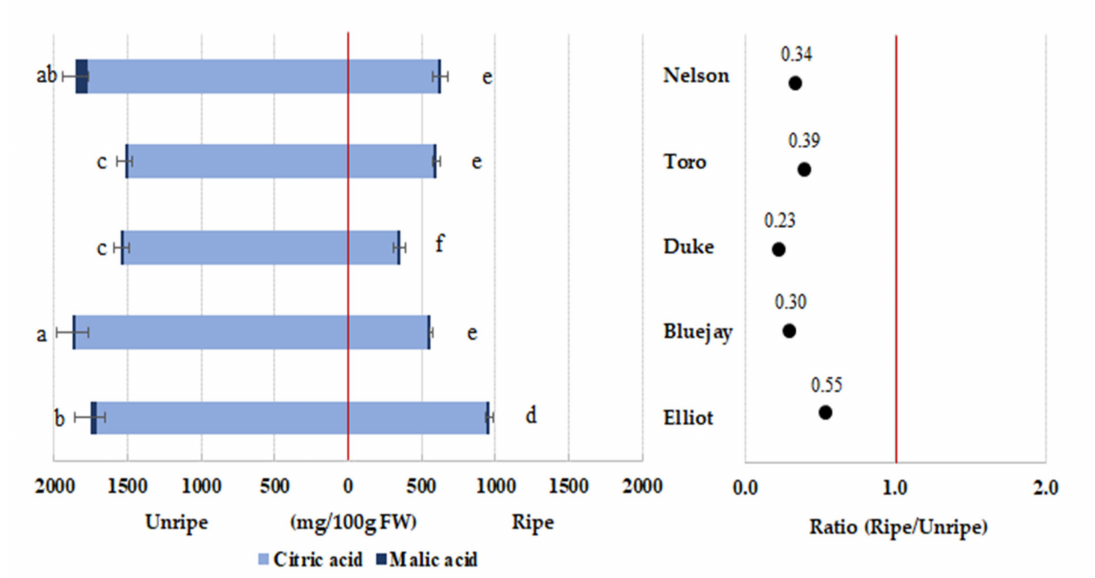
Figure 1. Di ff erent letters ( a – f ) are significant di ff erences by Duncan’s multiple range test ( p <